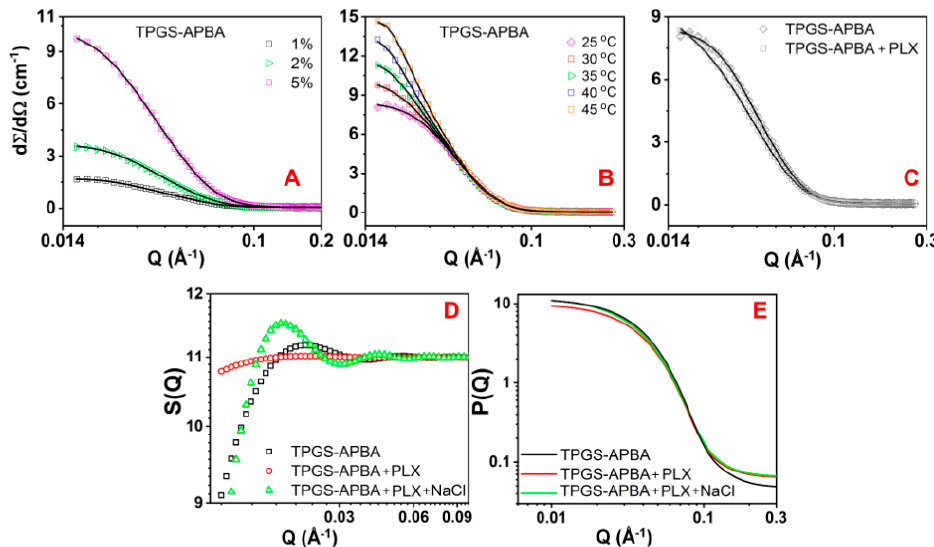
Figure 3. SANS profile showing the e ff ect concentration ( A ), temperature ( B ) and PLX incorporation ( C ) in TPGS-APBA micelles. Bottom panel shows changes in the structure ( D ) and form ( E ) factors of TPGS-APBA micelles upon incorporation of NaCl (0.9%) and